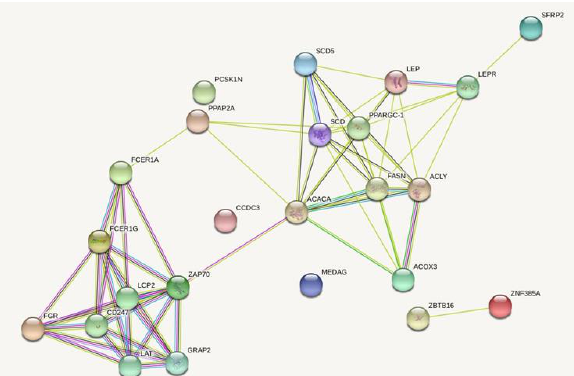
Figure 3. The detected differentially-expressed genes involved in GO terms related to lipid metabolism processes (String software based on Sus scrofa reference; detected genes showed no more than five interactions. Line shape indicates the predicted mode of action: red, interactions that were experimentally determined; blue, interactions from curated databases; black, co-expression; green, text mining associations and interactions based on relevant publications mentioning a transfer from other organisms; yellow, transcriptional regulation).